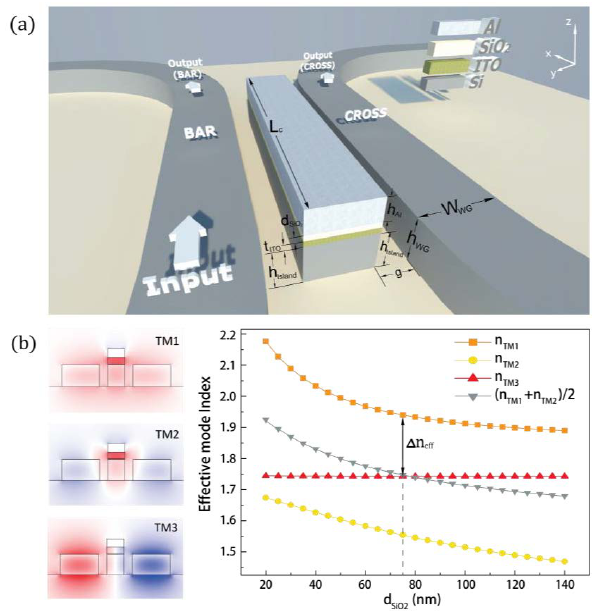
Figure 1: (a) Schematic of the proposed electro-optic switch. W WG = 450 nm wide and h WG = 250 nm high. Continuous wave light (TM polarized) is coupled from the WG Bar to the WG Cross port without a voltage bias (CROSS-state), and remains in the WG Bar upon bias- ing the island waveguide (BAR-state). (b) Effective mode index vs. thickness of oxide layer, associated with the eigenmode profiles for three TM supermodes (inset). g = 100 nm, λ = 1550